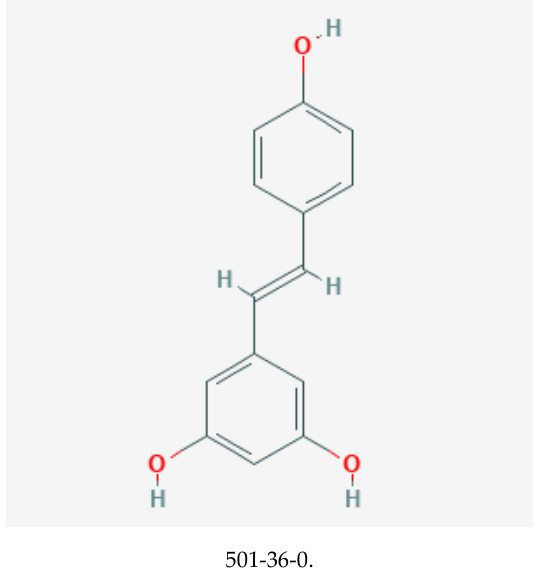
Figure 3. Chemical structure of resveratrol with its CASRN [68].